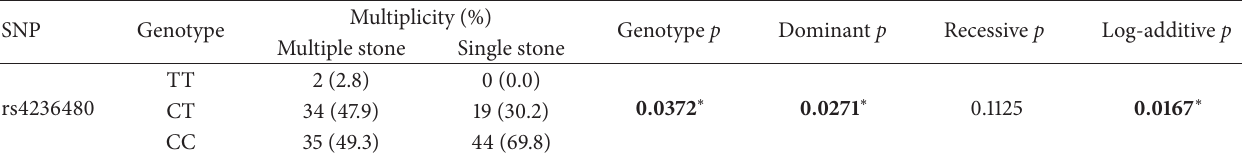
Figure 1: Graphical overview of the genotyped human TRPV5 gene. Table 2: Association analysis of TRPV5 rs4236480 and kidney stone multiplicity.